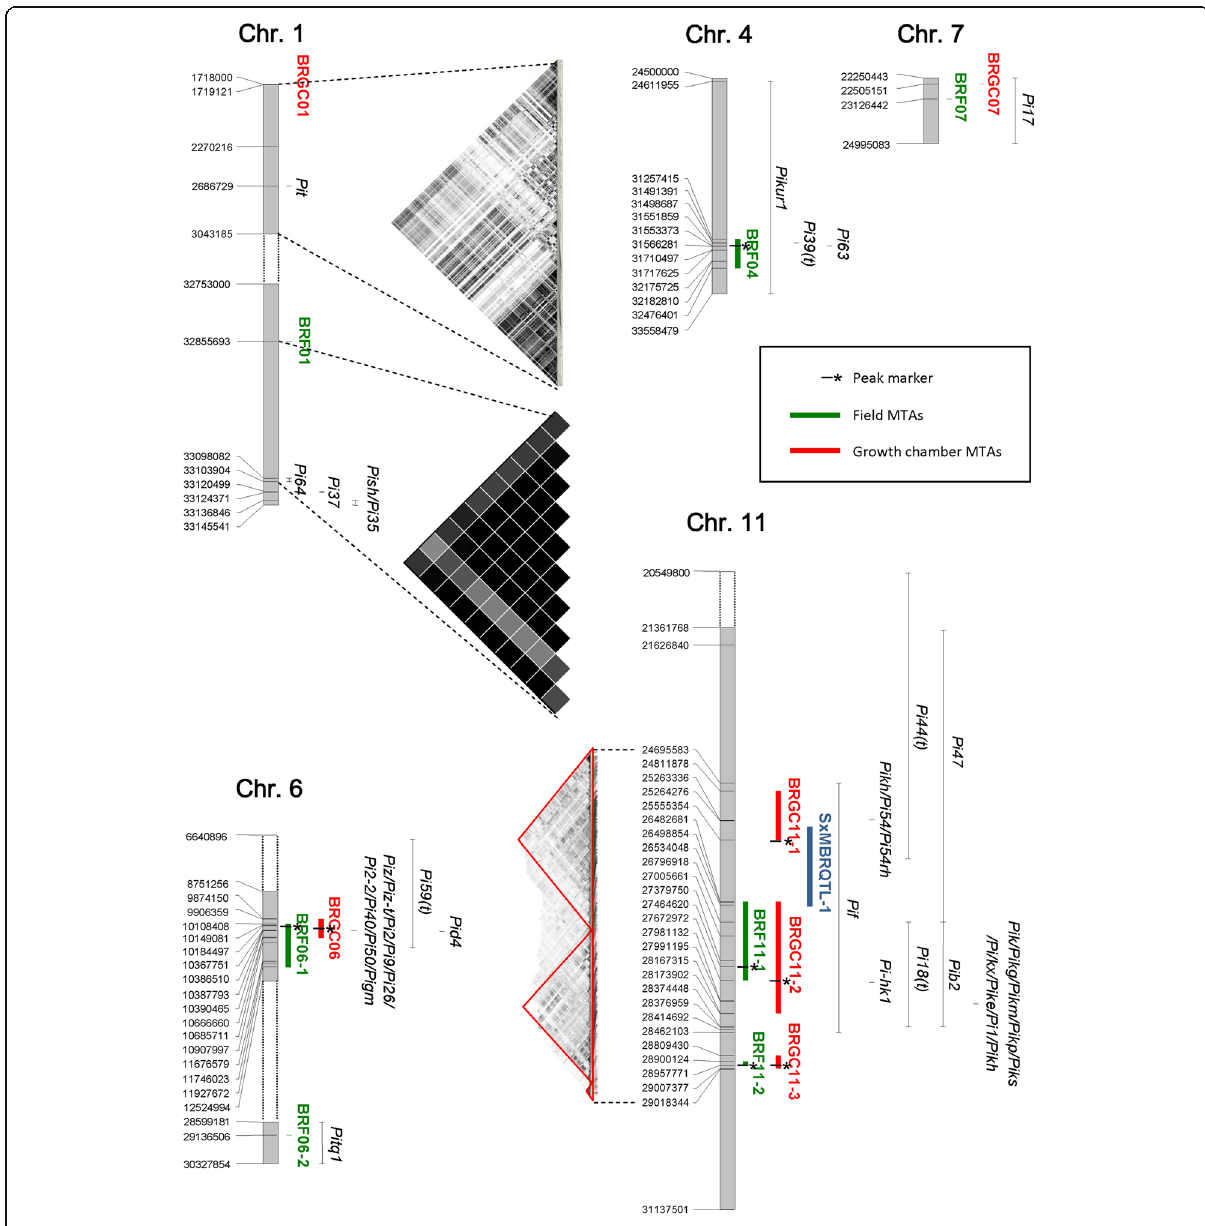
Fig. 3 Positional relationships of the significant associations detected in this work, as listed in Table 1 and Fig. 2, with respect to previously mapped or cloned blast resistance (R)-gene regions. BRF = MTAs detected in field conditions; BRGC = MTAs detected in growth chamber conditions. The position of the LD blocks on chromosome 1 and 11 is also